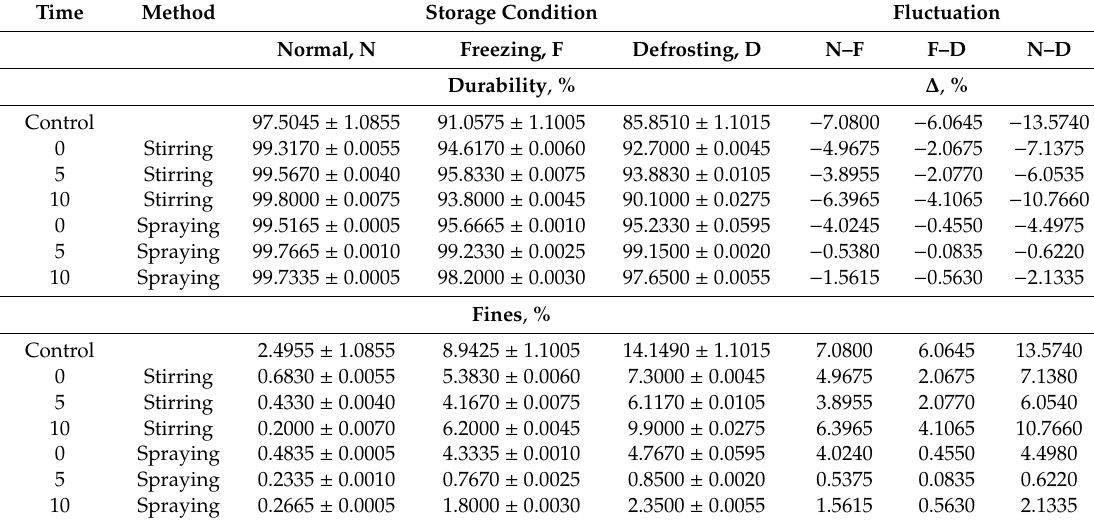
Table 4. Descriptive analysis for the durability and generation of fines of non-wood pellets with addition by stirring or spraying of liquid-state food waste subjected to the process of